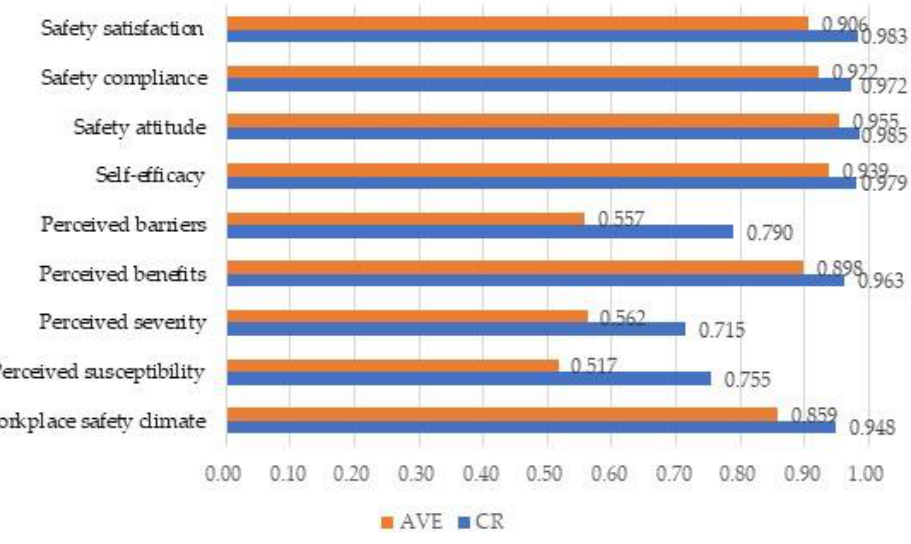
Figure 2. Graph of confirmatory factor analysis.